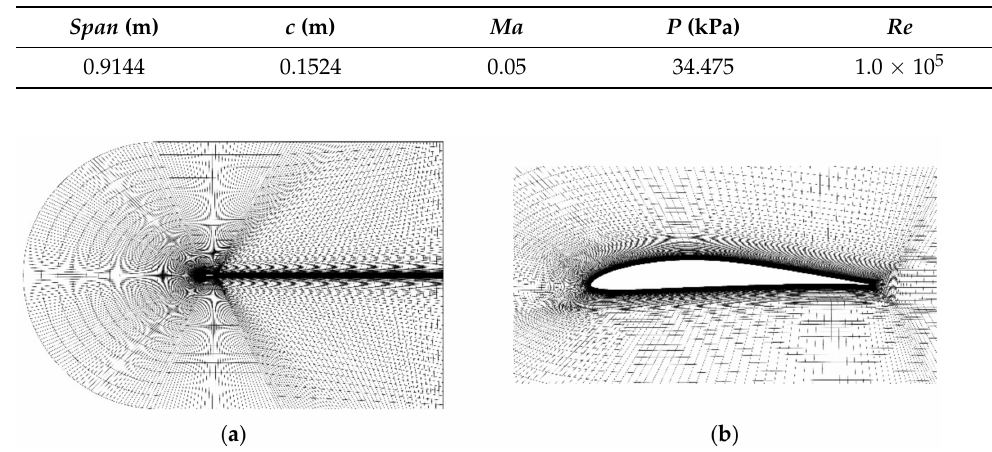
Table 1. Test conditions and parameters of the test model.